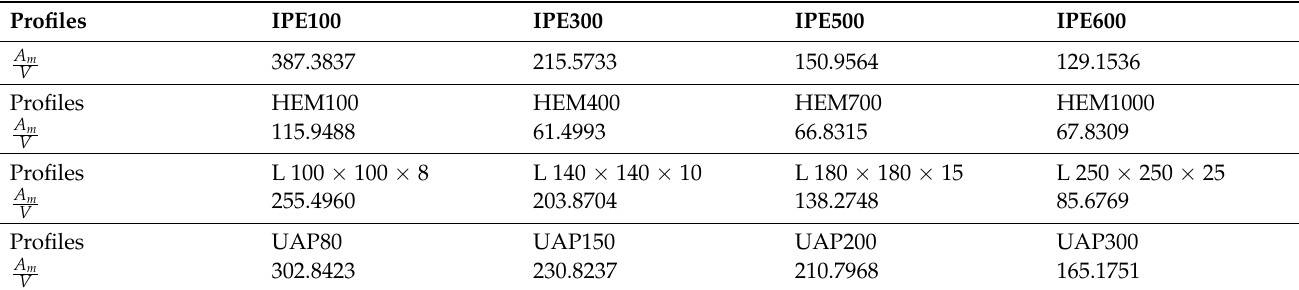
Table 1. Section factor values m − 1 .